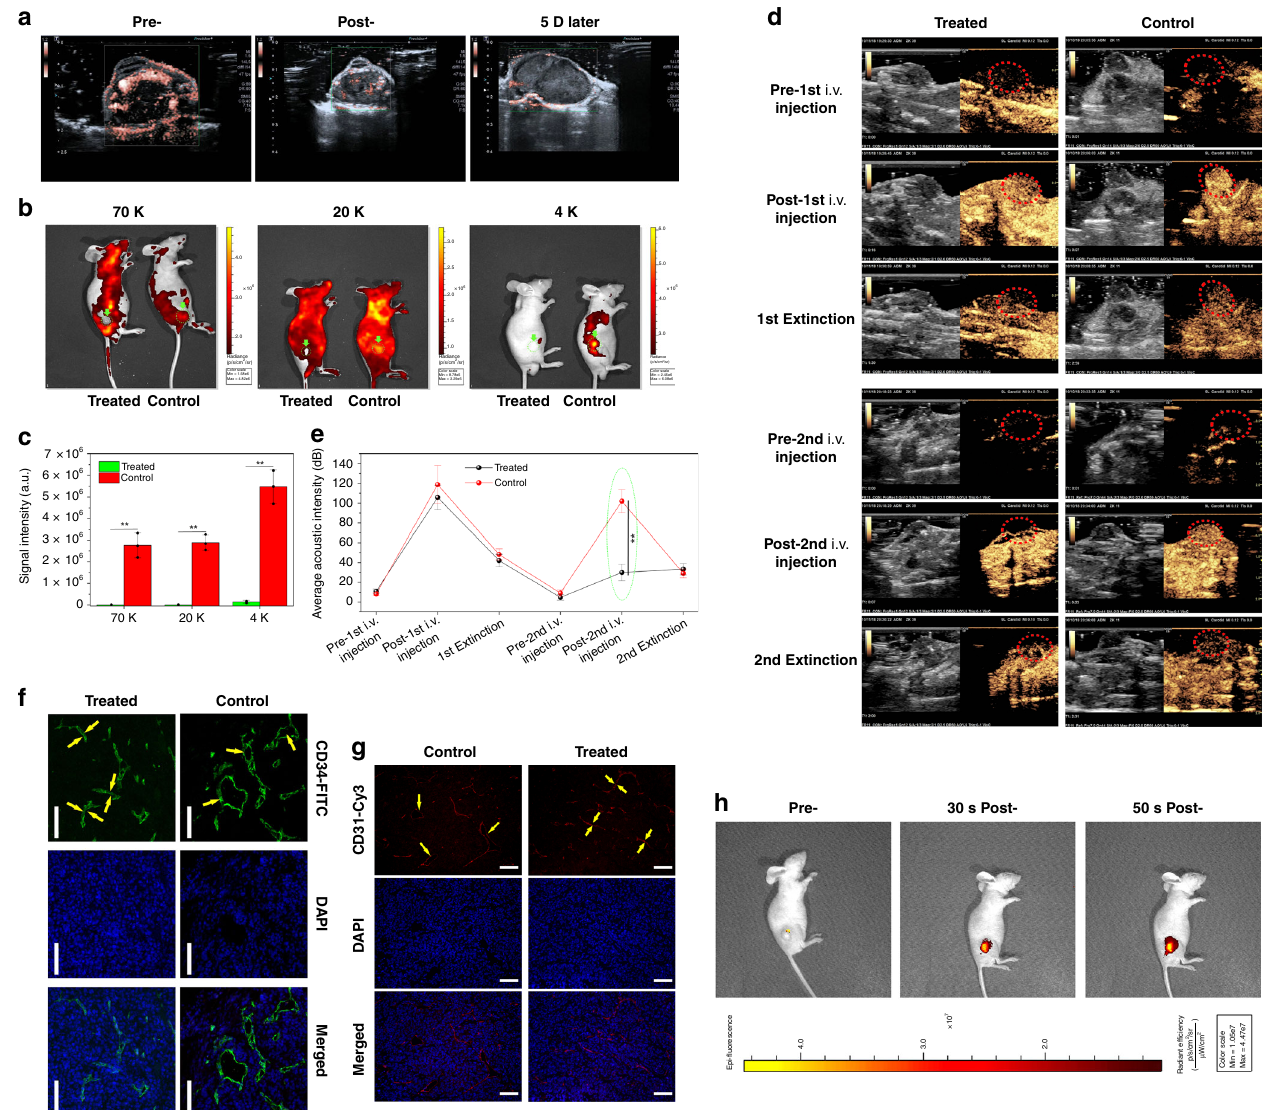
Fig. 4 In vivo evaluations on intratumoral vascular narrowing on PANC-1 xenografted pancreatic tumors. a CDFI images of PANC-1 xenografted pancreatic tumors implanted on nude mice that were captured at three time points, i.e., pre-, post- and 5 day post-treatment with Laser + hydrogel – GNR (2). b , c In vivo animal fl uorescence images ( b ) and quantitative signal intensities ( c ) of PANC-1 xenografted tumor after corresponding treatments in control (i.e., Laser + GNR) and treated (i.e., Laser + hydrogel – GNR (2)) groups and subsequent injections of different FITC-labeled dextrans with varied sizes (i.e., 70, 20, and 4 K), wherein green arrows and dotted ellipses indicate the tumor. Data are expressed as mean ± SD ( n = 3). d , e Time-dependent ultrasonic images ( d ) and average acoustic intensities ( e ) of PANC-1 xenografted tumor before and after corresponding treatments in control and treated groups, wherein the 1st i.v. injection of Sonovue TM microbubbles were carried out, and after 30 – 90 min, the corresponding treatments in two groups, i.e., control (Laser + GNR) and treated (Laser + hydrogel – GNR (2)), were implemented, followed by the 2nd i.v. injection of Sonovue TM microbubbles; and the ultrasonic images were captured at three time points, i.e., pre-, post-, and 40 – 120 s post- each i.v. injection of Sonovue TM microbubbles, and red dotted ellipses indicate the tumor. Data are expressed as mean ± SD ( n = 3). f , g Matured ( f ) and budding ( g ) blood vessels of PANC-1 xenografted tumors after corresponding treatments in control and treated groups, and they were stained by FITC-labeled CD34 immuno fl uorescence ( f ) and Cy3-labeled CD31 immuno fl uorescence ( g ), respectively, scale bar: 200 μ m. Yellow arrows indicate the intratumoral blood vessels. ( h ) In vivo animal fl uorescence imaging of nude mice-bearing PANC-1 xenografted tumor at three time points, i.e., pre-, 30 s post- and 50 s post-i.t. injection of Cy3-labeled dextrans-grafted hydrogels, wherein Cy3-labeled dextran (size: 70 K) instead of GNRs was used. Statistical signi fi cances were obtained using unpaired student's t test, ** P < 0.01. Note: Laser + hydrogel – GNR (2) represent the co-injection of hydrogel – GNR in tumor and its periphery and subsequent 808 nm laser